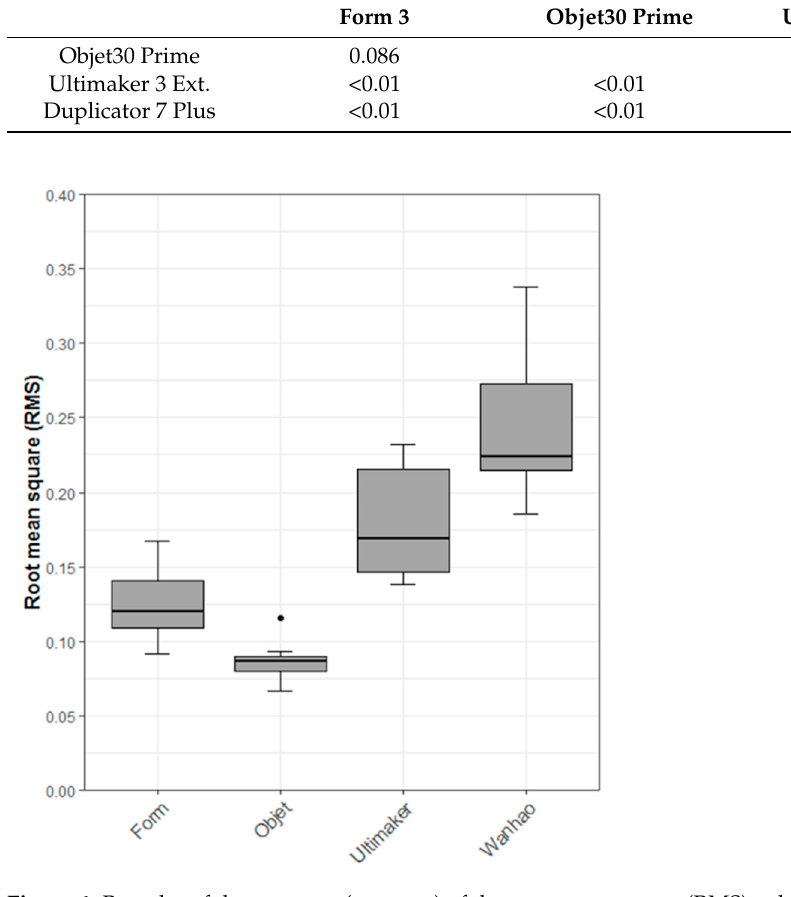
Figure 4. Box plot of the accuracy (trueness) of the root mean square (RMS) values (in mm) for each 3D printer.